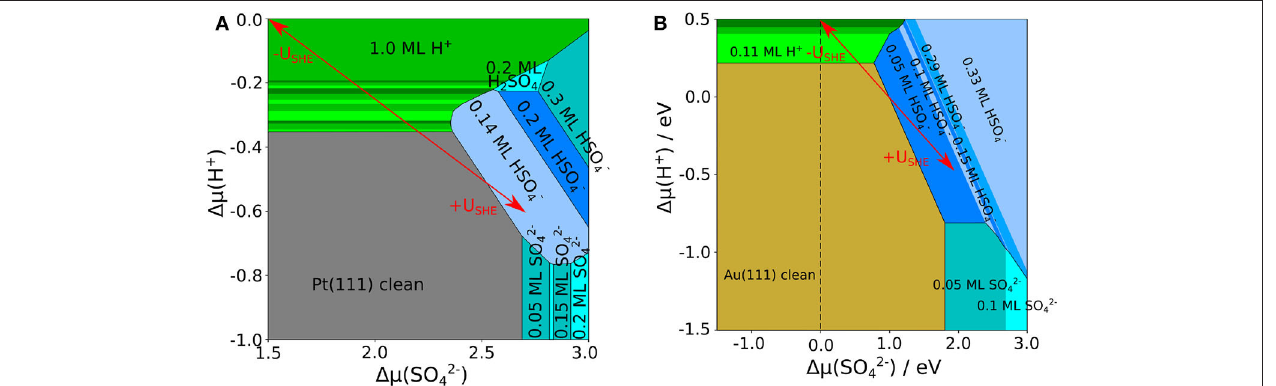
FIGURE 2 | Phase diagram of sulfate, bisulfate, and hydrogen adsorption on (A) Pt(111) and (B) Au(111), as a function of the electrochemical potential of protons and of sulfate anions, using an implicit water model. The uncovered metal electrodes are indicated in gray [Pt(111)] or in brown [Au(111)], respectively; green: pure hydrogen coverage; blue: pure sulfate or bisulfate coverage. The red arrows indicate the effect of varying the electrode potential for fixed concentrations of the species.